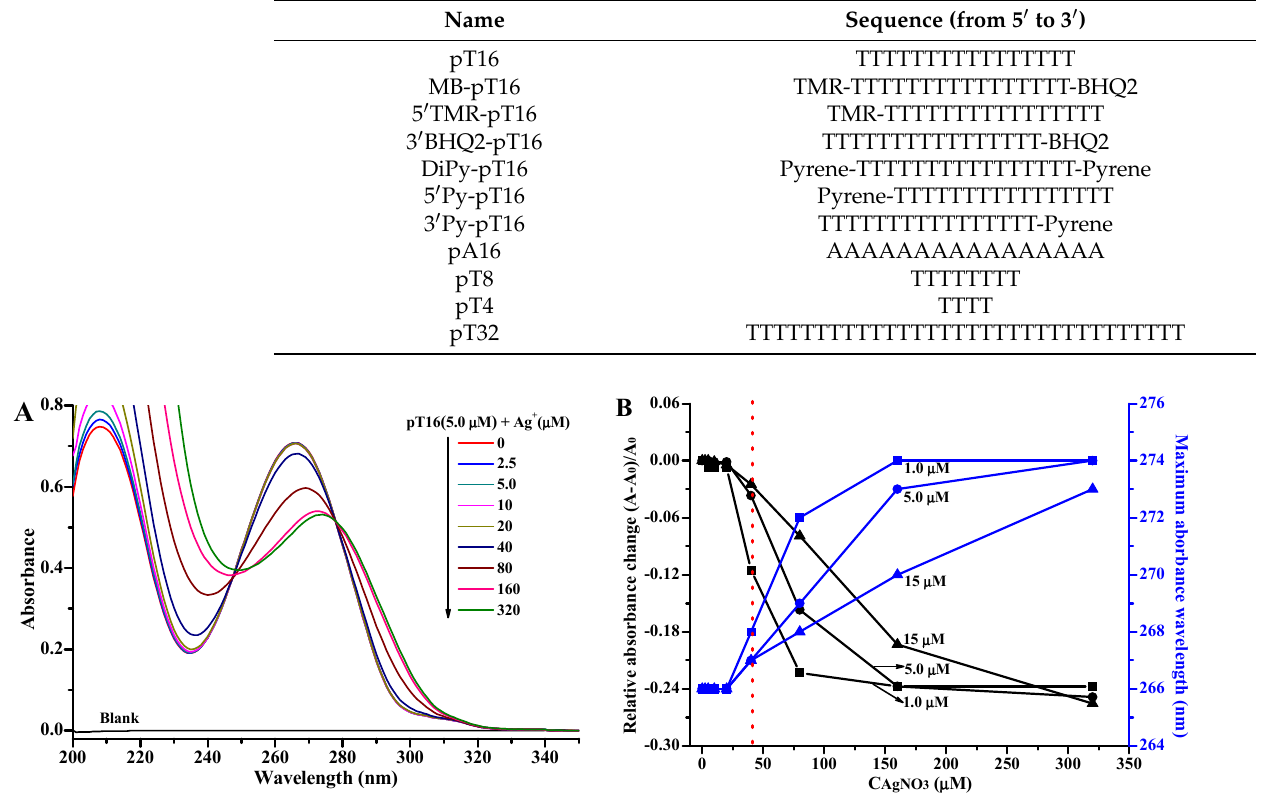
Figure 1. ( A ) UV absorption spectra of 5.0 µ M pT16 in the absence and presence of 2.5, 5.0, 10, 20, 40, 80, 160, and 320 µ M AgNO 3 . ( B ) Plots of the relative absorbance change (left, black) and wavelength (right, blue) at the maximum absorption against the concentration of AgNO 3 for pT16 solutions at 1.0 µ M (square), 5.0 µ M (circle), and 15 µ M (uptriangle). The samples were prepared in 10 mM Tris-HAc buffer pH 7.0. A 0 and A are the absorbance at maximum absorption of the oligonucleotide solutions in the absence and presence of AgNO 3 , respectively. Table 1. The names, sequences, and modifications of the DNA oligonucleotides presented in this work.